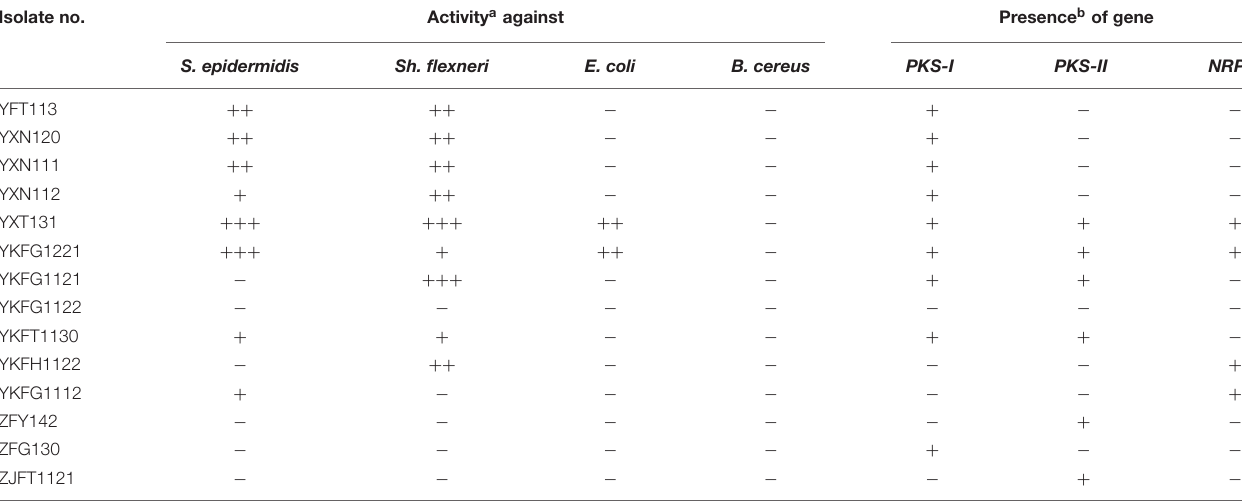
TABLE 5 | Antimicrobial activities and PKS / NRPS genes of culturable actinobacteria from Zijuan and Yunkang-10. Isolate